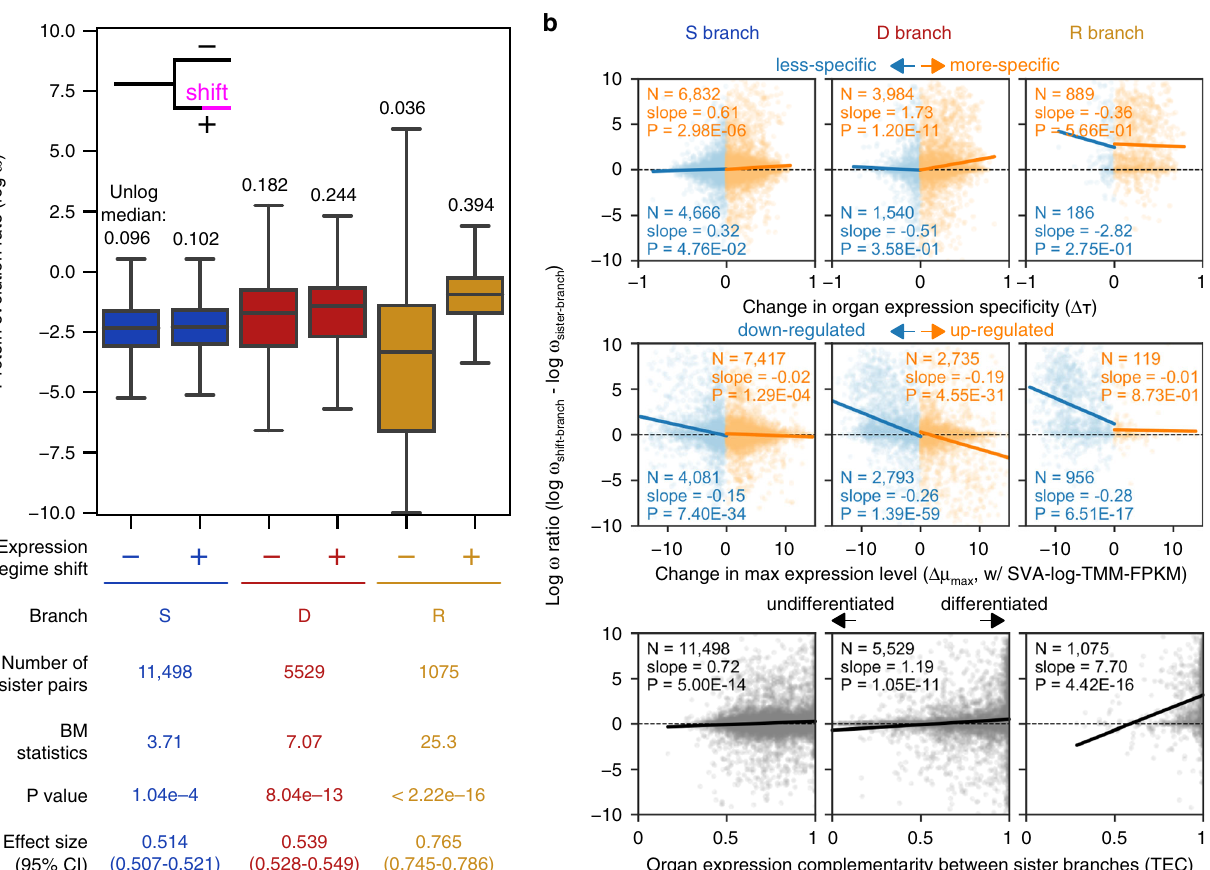
Fig. 4 Context-dependent changes of protein evolution rate coupled with expression regime shifts. a Distribution of ω values. A plus ( + ) indicates branches with expression shifts, whereas minus ( − ) branches are sisters to the plus branches. Statistical differences between pairs of distributions were tested using a two-sided Brunner – Munzel test 95 . Non-log-transformed median values are shown above the boxplots. For visualization purposes, extreme values exceeding ±10 were clipped. Boxplot elements are de fi ned as follows: center line, median; box limits, upper and lower quartiles; whiskers, 1.5 × interquartile range. b Relationships between protein evolution rate and change in expression properties. Points correspond to expression regime shifts. Dashed lines indicate no between-branch difference in ω . Solid lines show a linear regression. Its slope and number of regime shifts are provided in the plot. Regime shifts with negative and positive changes were separately analyzed for organ expression speci fi city (upper) and maximum expression level (middle). P values indicate whether the slopes were signi fi cantly different from zero (two-sided t